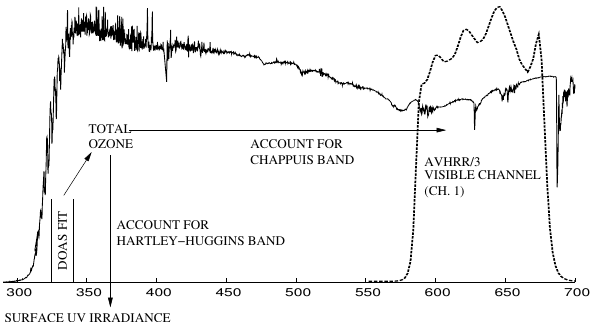
Figure 2. UV–VIS reflectance spectrum (solid line) together with AVHRR/3 channel 1 spectral response function (dotted line) il- lustrating the use of the total ozone column product derived from 325–335nm fitting window. The total ozone column accounts both for the Hartley–Huggins band (up to ca. 350nm) absorption in the surface UV irradiance calculation (280–400nm) and the Chappuis band absorption (wide band covering the whole visible region with two maxima around 575 and 600nm) in retrieving the cloud optical depth from the AVHRR/3 channel 1